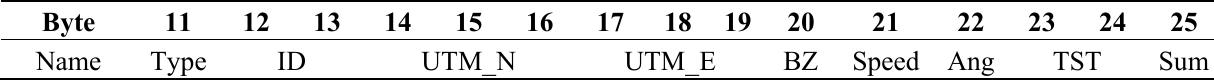
Table 3. GeoData field. UTM_N, north UTM coordinates; UTM_E, east UTM